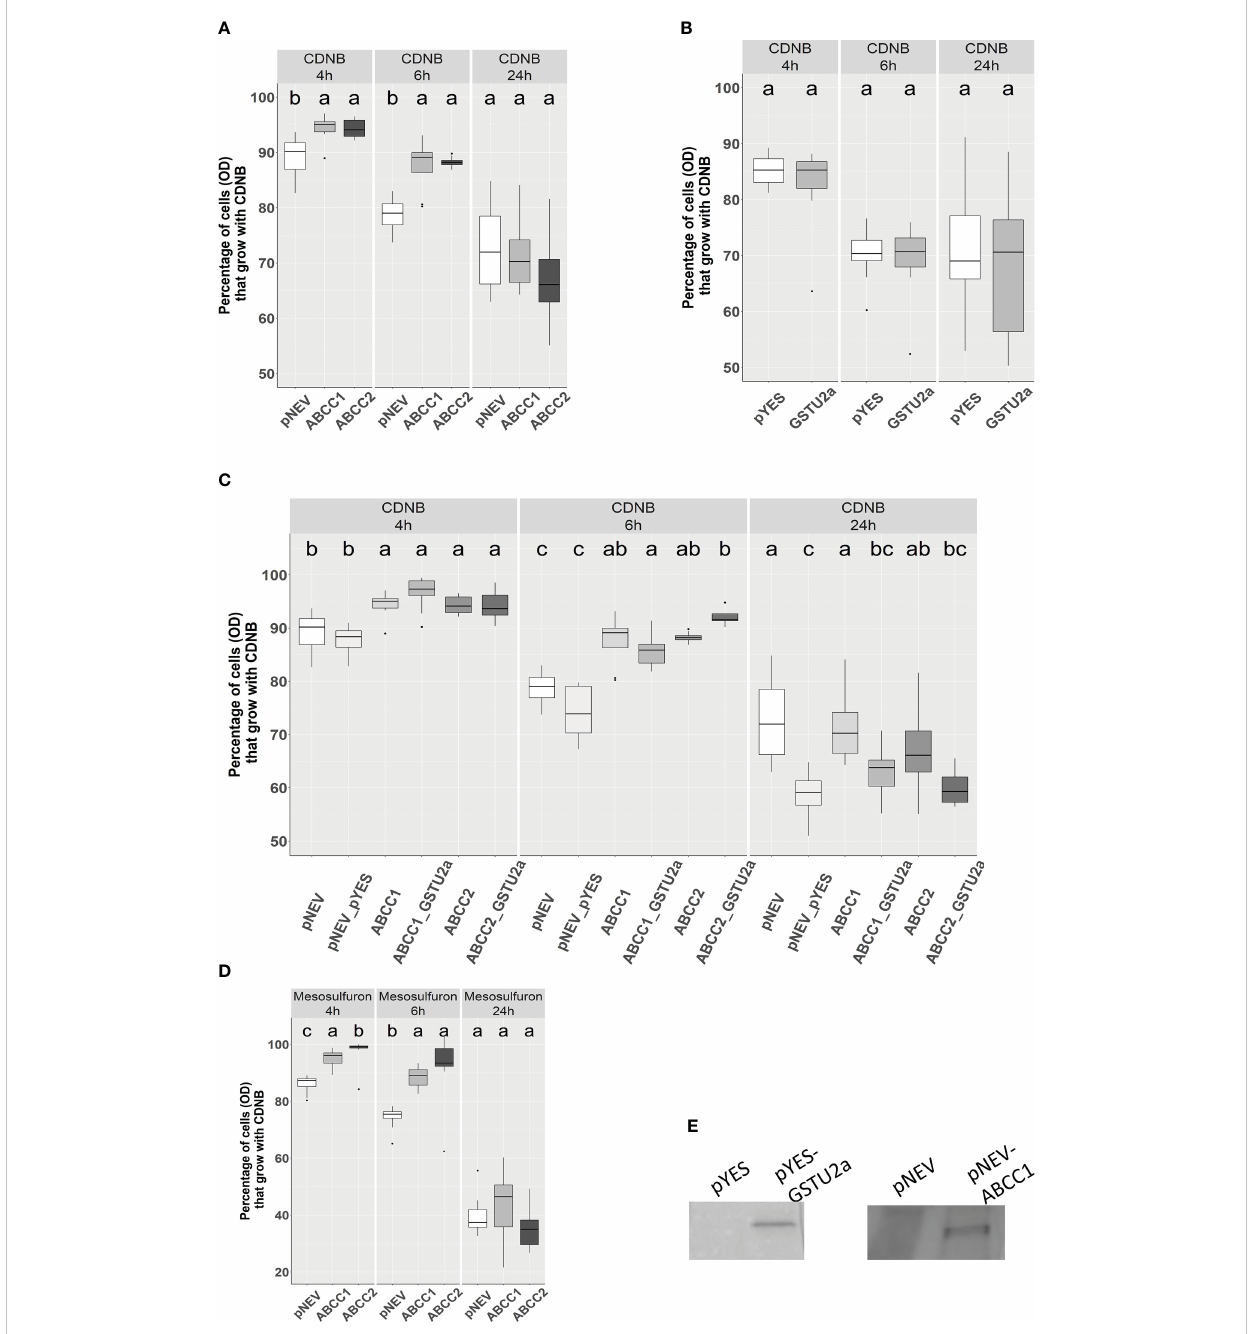
FIGURE 6 Effect of heterologous expression of Am ABCC1 or Am ABCC2 in yeast cells on tolerance to CDNB and mesosulfuron-methyl. (A) Effect of CDNB on D ycf1 yeast cells transformed with either empty vector (pNEV), Am ABCC1, or (B) Am ABCC2. (C) Growth of native yeast transformed with empty vector (pYES), Am GSTU2a, or transformed with a combination of both vectors (pNEV + pYES) encoding each transporter along with Am GSTU2a. (D) .Effect of mesosulfuron-methyl on the growth of D ycf1 yeast transformed with either empty vector (pNEV), Am ABCC1 or Am ABCC. (E) Cell extracts of yeast transformed with either empty vector (pNEV or pYES), or the respective vector containing Am ABCC1 or Am GSTU2 immunoblotted with antibodies raised against Am ABCC1 or Am GSTU. In each case, cells were grown to an OD 600 = 0.15 and then either left untreated, or exposed to 40 m M CDNB, or 20 m M mesosulfuron-methyl. The OD was then recorded at 4, h, 6 h and 24 h post treatment. Data was obtained from three independent experiments with results expressed as % growth compared to untreated cultures. The different letter represent statistically difference among blackgrass